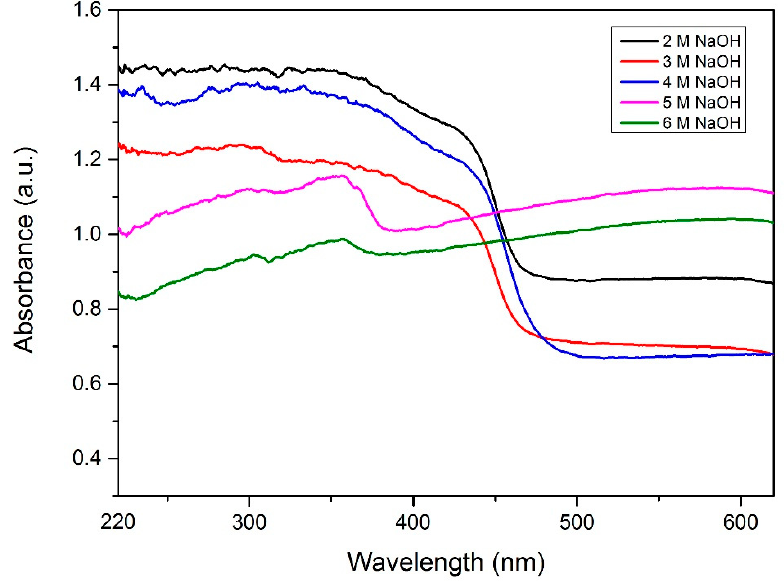
Figure 3. UV-Vis absorption spectra for the sample synthesized with different concentrations of NaOH.